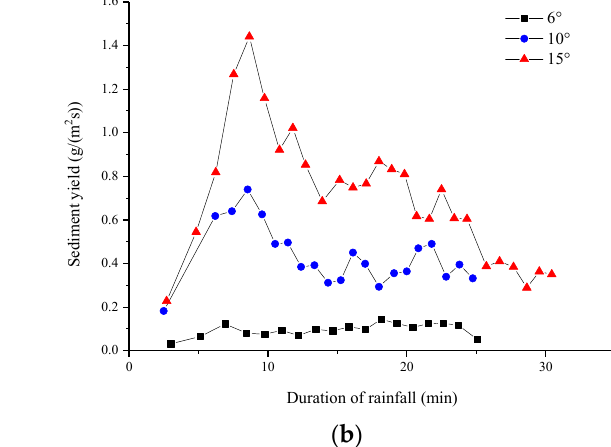
Figure 2. Runoff yield process of slope. ( a ) Slope was 15°.and ( b ) rainfall intensity was 3.0 mm/min. Under the same slope condition, the erosional sediment yield on the slope increased sharply with the increase in rainfall intensity at first and then decreased gradually to the peak value until it reached dynamic stability (Figure 3a). The peak value of sediment yield under 3.0 mm/min rainfall intensity (0.74 g (m 2 s) − 1 ) was 1.34 times and 2.96 times that under 2.5 and 2.0 mm/min rainfall intensity. With the same rainfall intensity (3.0 mm/min), the sediment yield on the slope was positively proportional to the slope (Figure 3b). The peak value of sediment yield reached about 10 min after rainfall, and the peak value of sediment yield increased significantly with the increase in slope. The peak sedi- ment yield (1.44 g (m 2 s) − 1 ) on the 15° slope was 1.95 times and 11.74 times that on the 10° and 6° slopes. In the process of early rainfall, there was no rill erosion, only splash erosion. The runoff form was a slope thin-layer flow; its kinetic energy was small, and the sediment yield process was mainly the transport of spattered soil particles and the layered denuda- tion of the soil surface under inter-rill erosion. With the increase in rainfall duration, sur- face particles were transported, runoff intensity increased, and the soil crust was de- stroyed. The sediment yield increased significantly after the rill appeared but decreased and tended to be stable after the dynamic equilibrium. Figure 3. Sediment yield process of slope. ( a ) Slope was 15° and ( b ) rainfall intensity was 3.0 mm/min.